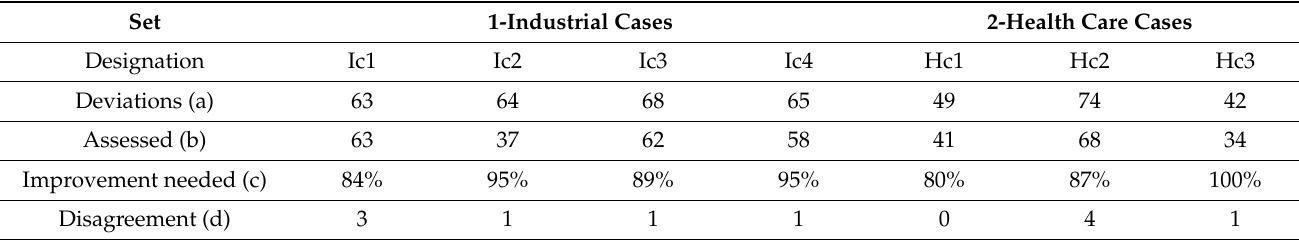
Table 6. Deviations in event investigations with the combined method